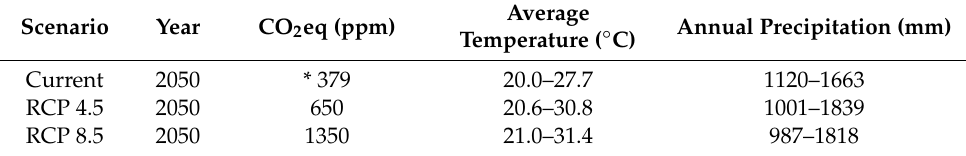
Table 8. Temperature and precipitation for the municipality of Acapulco